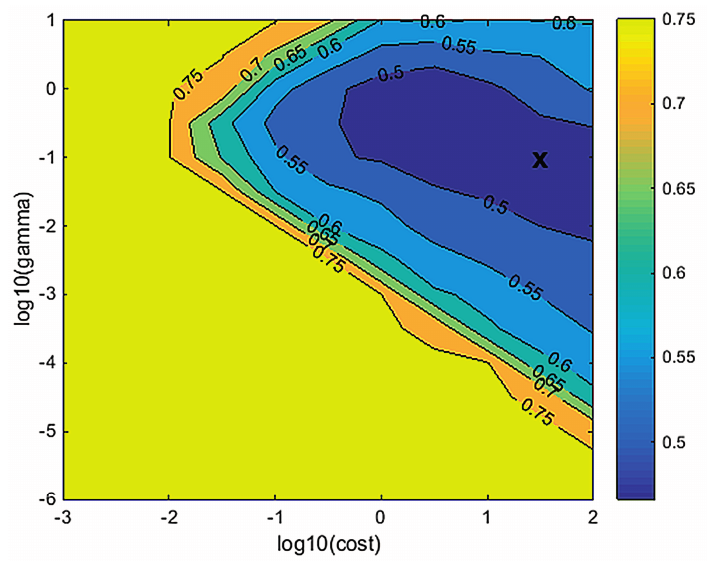
Figure 4. Misclassification fraction by cross-validation in